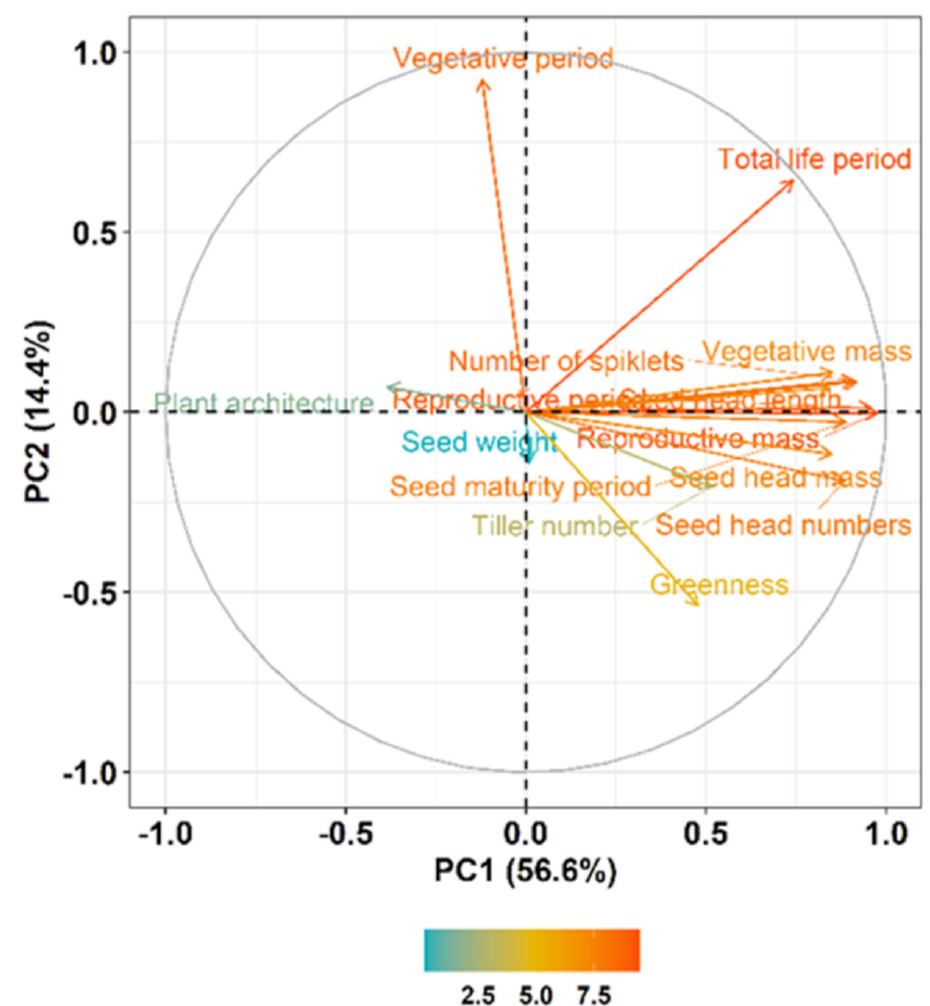
Figure 6. Principal component analysis (PCA) of plant morphological and reproductive features of feathertop Rhodes grass. The first axis explains 56.6% and the second axis 14.4% of the variance. The color of the arrows (in the bottom scale 0 to 10) represents the degree of the variation affected by different sowing